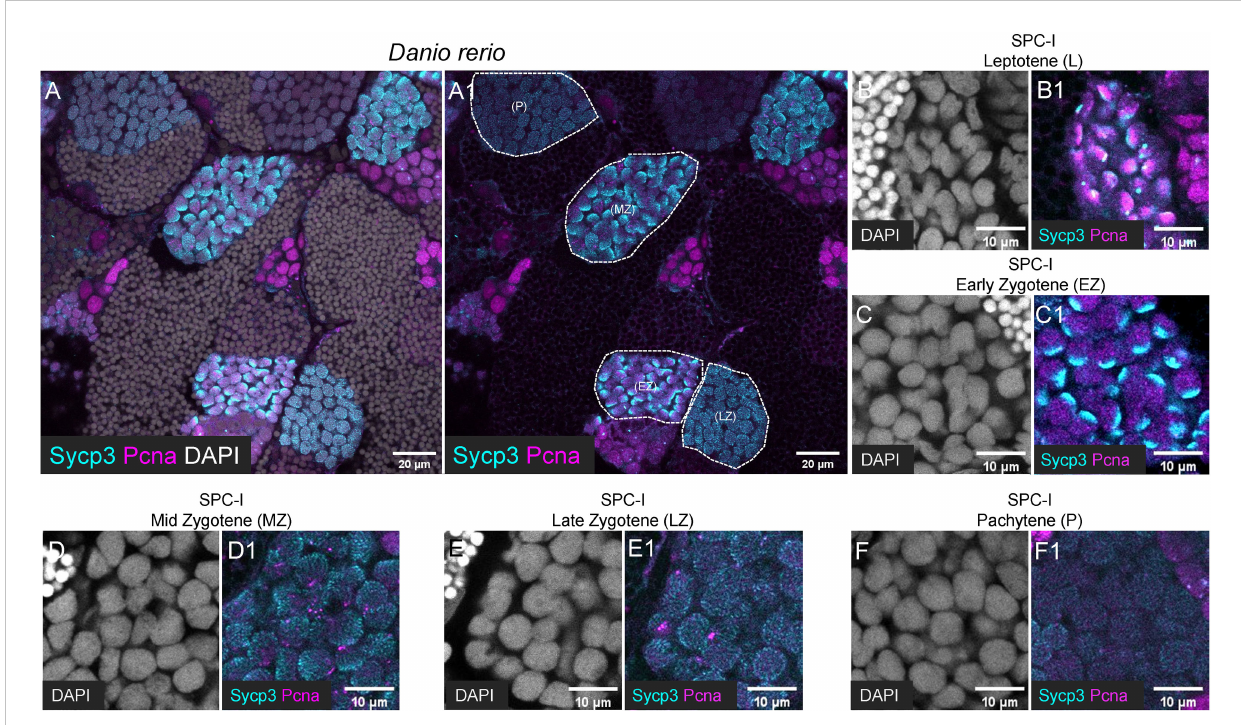
FIGURE 4 Characterization of different subtypes of SPC-I by co-staining of Sycp3 and Pcna. (A, A1) The representative images of a zebra fi sh testis section showing the co-staining of Sycp3 (cyan), Pcna (magenta) and DAPI (grey). (B-F, B1-F1) The representative image showing the SPC-I (Leptotene/L) (B, B1) , the SPC-I (Early Zygotene/EZ) (C, C1) , the SPC-I (Mid Zytotene/MZ) (D, D1) , the SPC-I (Late Zygotene/LZ) (E, E1) and the SPC-I (Pchytene/P) (F, F1) . Different subtypes of SPC-I are circled by dashed